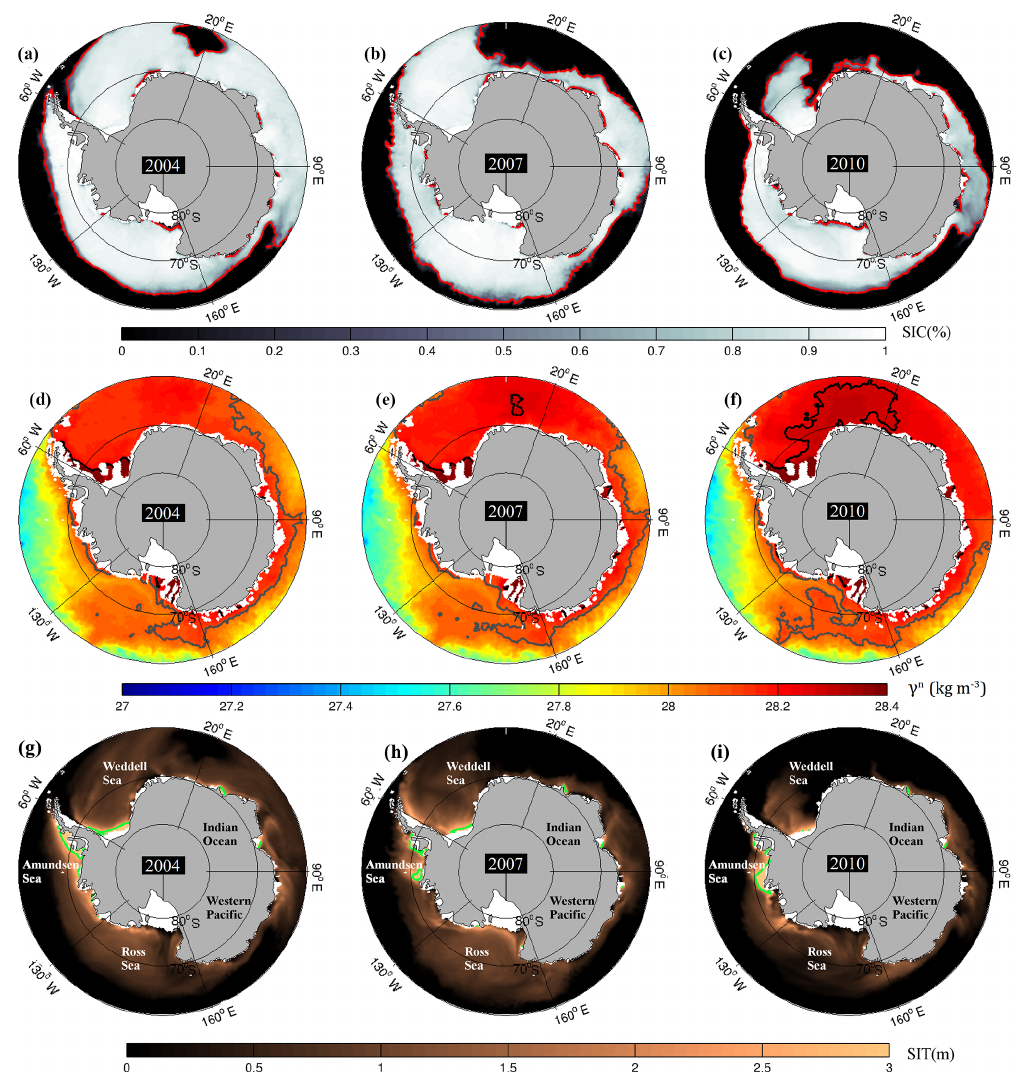
Figure 11. (a) , (b) and (c) are the mean ECCO2 sea ice concentrations in November of 2004, 2007, and 2010, respectively. The red contours delineate the 30% sea ice concentration, which is the border of the polynya. The straight black lines separate each Southern Ocean sector analyzed. (d) , (e) and (f) are the mean neutral density filled contours at 700m for November of 2004, 2007, and 2010, respectively. The gray lines delineate the 28.1kgm − 3 neutral density of WDW and the black lines the 28.27kgm − 3 of the WSDW. (g) , (h) and (i) are the mean ECCO2 SIT (m) in November of 2004, 2007, and 2010, respectively. The green contours delineate areas with SIT greater than